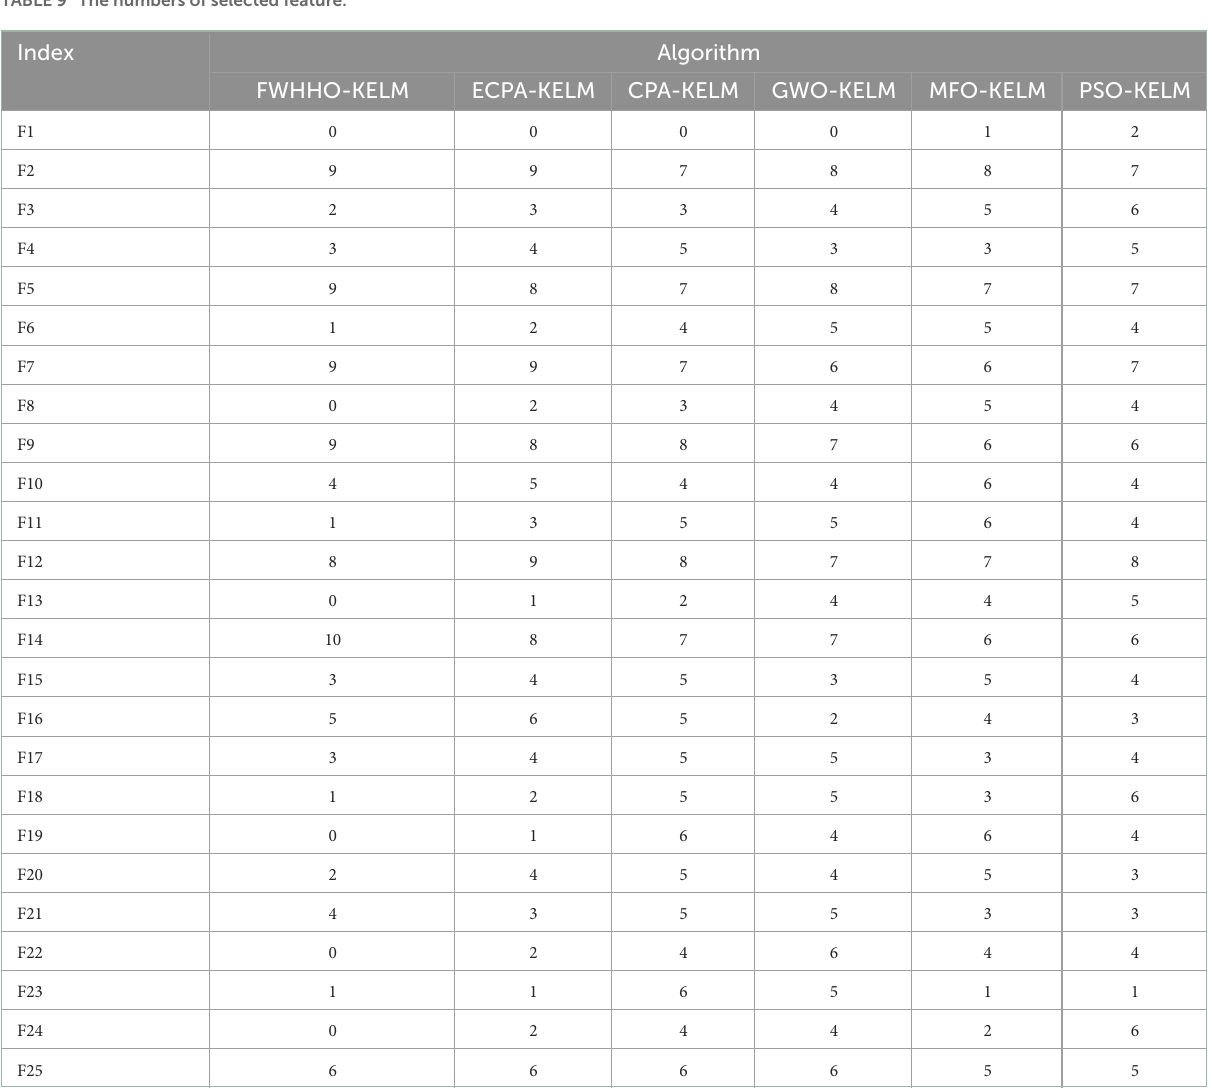
TABLE 9 The numbers of selected